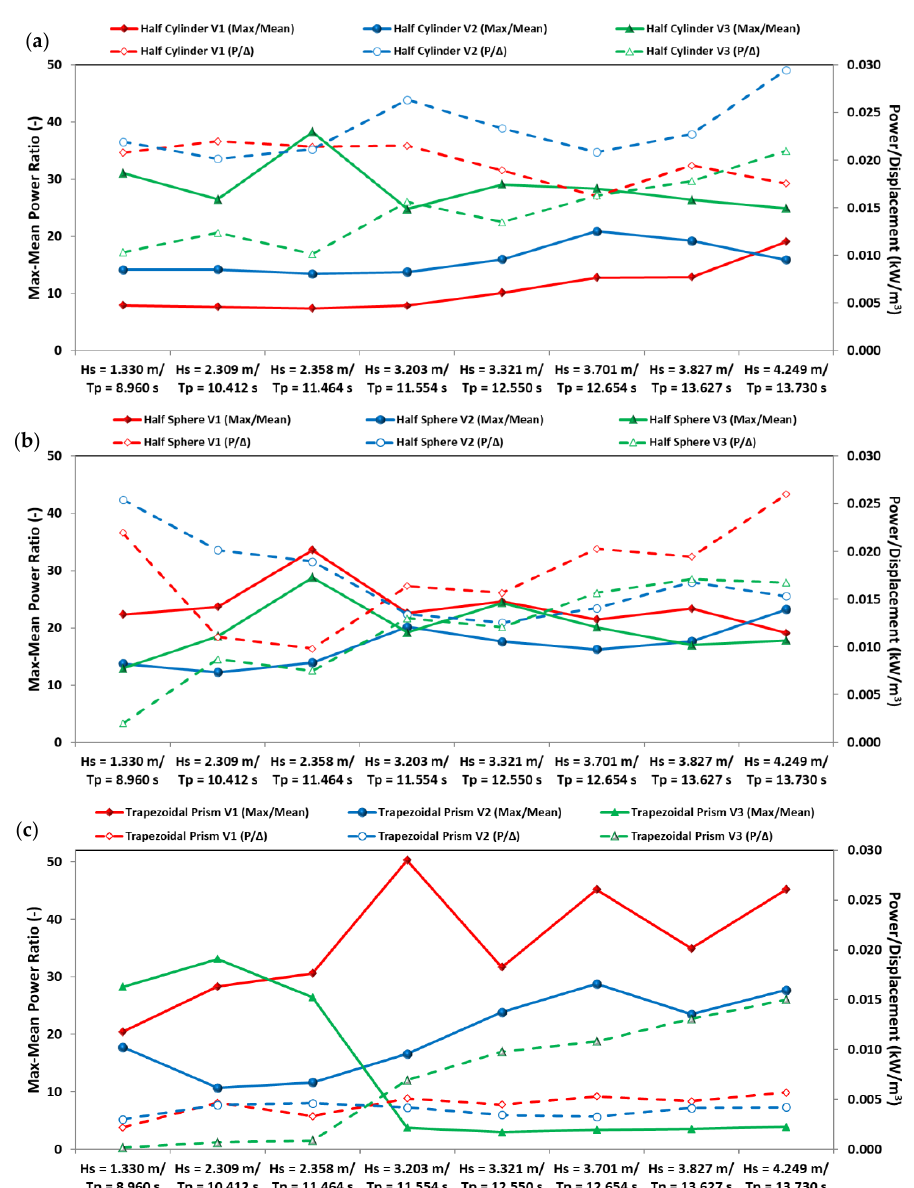
Figure 14. Max-mean power ratios (left) and average power output per cubic meter of displaced volume (right), in prototype values: ( a ) HC, ( b ) HS and ( c ) TP sub-variants. Following on the E- Motions’ power output results, the unidirectional lateral TENG was implemented inside the HC (which resulted in the largest output power from complementary tests under regular waves [71]) for the V1 variant. The open-circuit voltage was acquired using a Bluetooth datalogger that transmitted data in real time to a nearby personal computer. This implementation prevented extra cables from being connected to the HC, which could affect its hydrodynamic response. The open-circuit voltage (VOC) under the eight sea states (bins) considered in the experimental study, with irregular waves, is presented in Figure 15a. An average open-circuit voltage (<VOC>) and power density of ~ 85 V and 182 mW/m2, respectively, was achieved for sea state 1, which